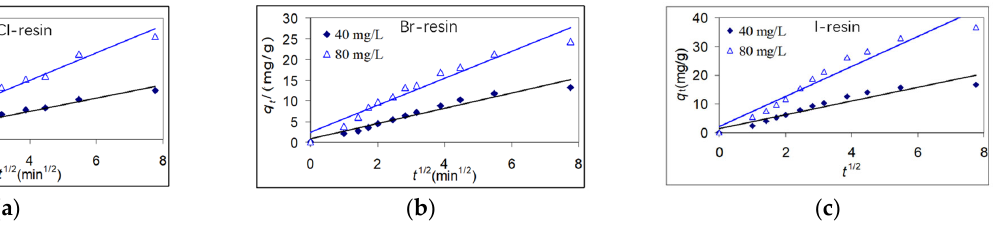
Figure 5. Intra particle di ff usion plots of Cd 2+ adsorption on X − loaded resins. ( a ) Cl resin, ( b ) Br resin, ( c ) I resin.